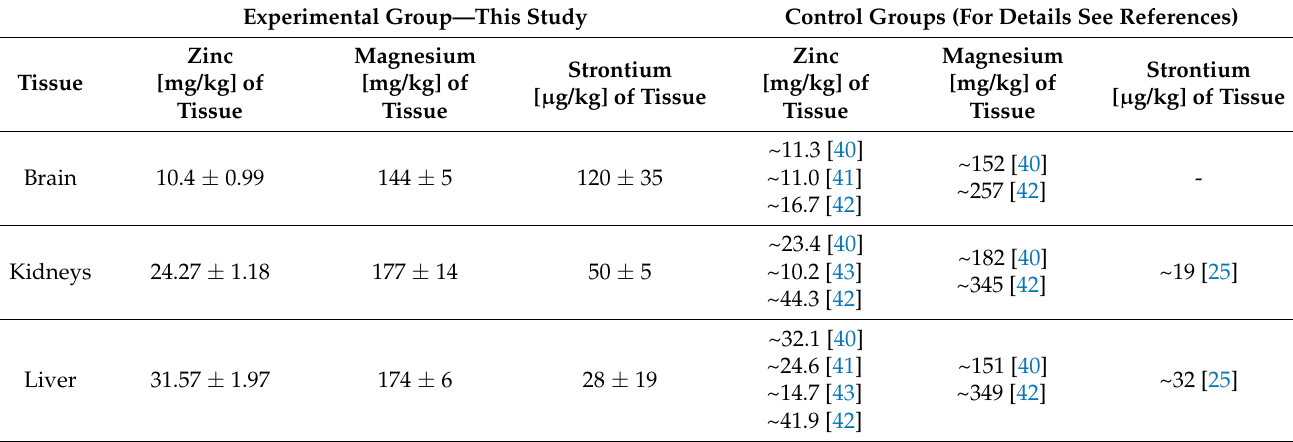
Table 3. Organ analysis of Magnesium, Zinc and Strontium content, mean ±